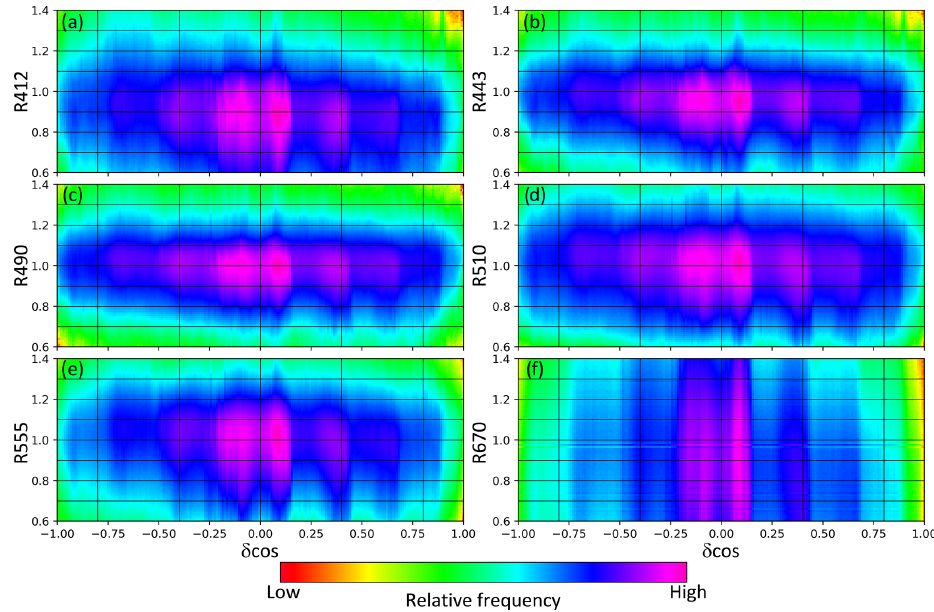
Figure 3. 2-D frequency histogram of the daily Rrs ratio ( R , on the y axis) and the difference of the cosine of the scattering angle ( δ cos) between MODIS Aqua and VIIRS for each of the six bands of the Multi product (2012–2017). The scattering angle ( (cid:50) s ) is defined as (cid:50) s = 180 θ 0 (cid:1) cos (cid:0) π θ S (cid:1) − sin (cid:0) π θ 0 (cid:1) cos (cid:0) π ϕ r (cid:1)(cid:1) , with θ 0 , θ S , ϕ r being the solar and sensor zenith angles and the relative arccos (cid:0) − cos (cid:0) π π 180 180 180 180 azimuth angle, respectively. R exhibits substantial variability across the spectrum with the values shown in panels (a) and (f) presenting the larger differences. Overall, the median values of the Rrs ratios at the six bands are within the range 0.9–1.1. The noticeable feature is the lack of any dependency of R from the geometry of the observation ( δ